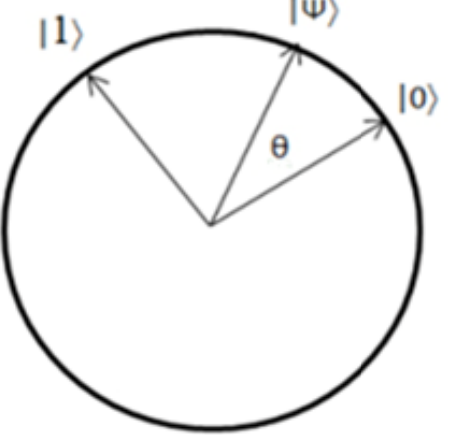
Figure 10. Quantum state |Ψ ⟩ after rotation of θ in Hilbert space.